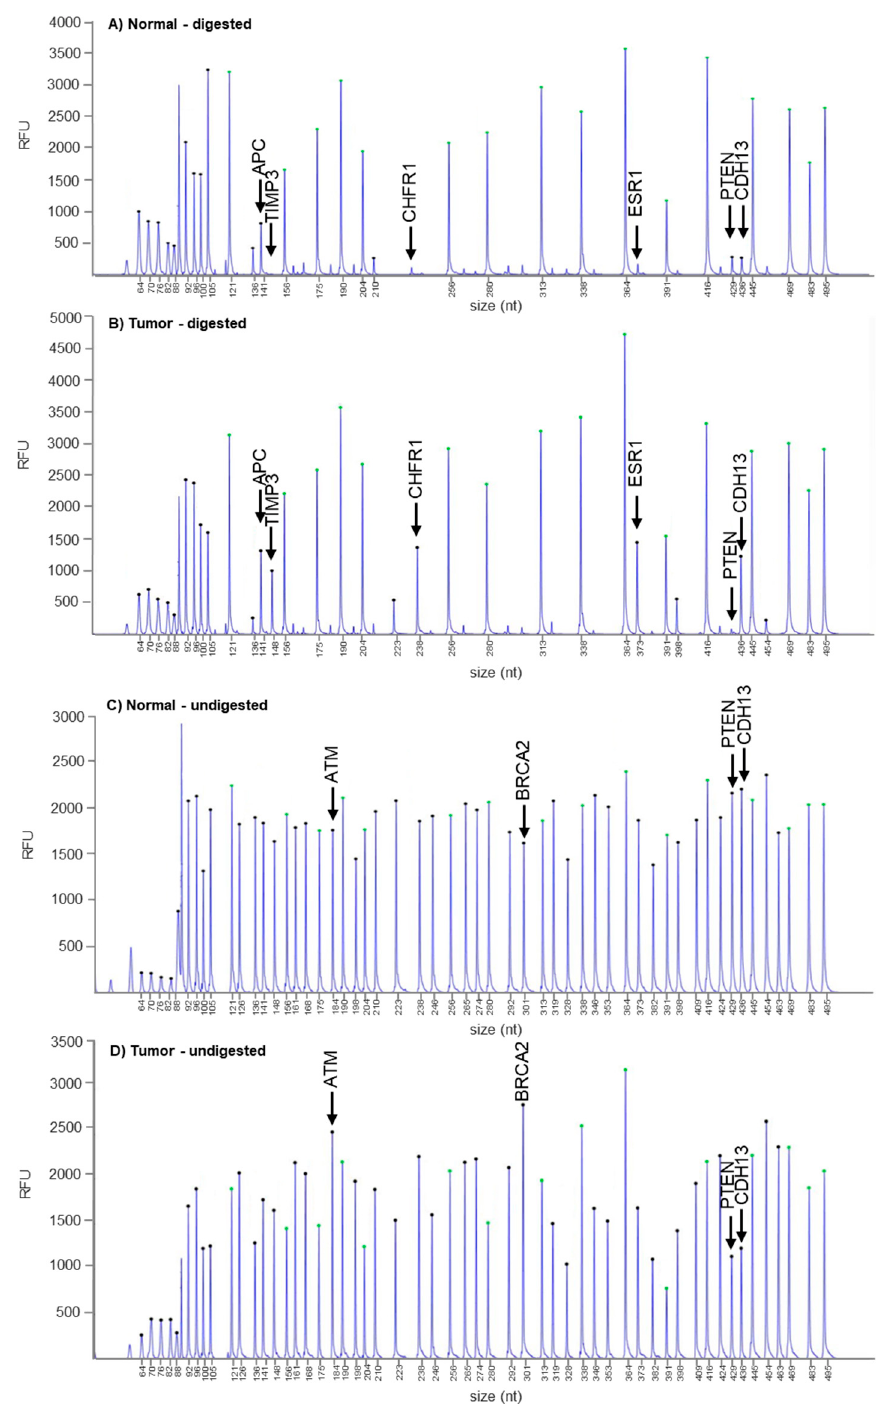
Figure 3. Detection of methylation and aberrant copy number variations in tumor compared to normal tissue from the index patient. ( A , B ) MS-MLPA assay with HhaI enzyme treatment for methylation analysis in normal ( A ) and tumor ( B ) GEJ tissue from the index patient showing APC, ESR1, CHFR1, CDH13 , and TIMP3 hypermethylation (methylation ratio 40–65%) in tumor tissue. ( C , D ) MS-MLPA assay without HhaI enzyme treatment for copy number analysis in normal ( C ) and tumor ( D ) GEJ tissue from the index patient showing PTEN and CDH13 losses (copy number ratio: 0.5 and 0.63, respectively) and ATM and BRCA2 gains (copy number ratio: 1.43 and 1.58, respectively) in tumor